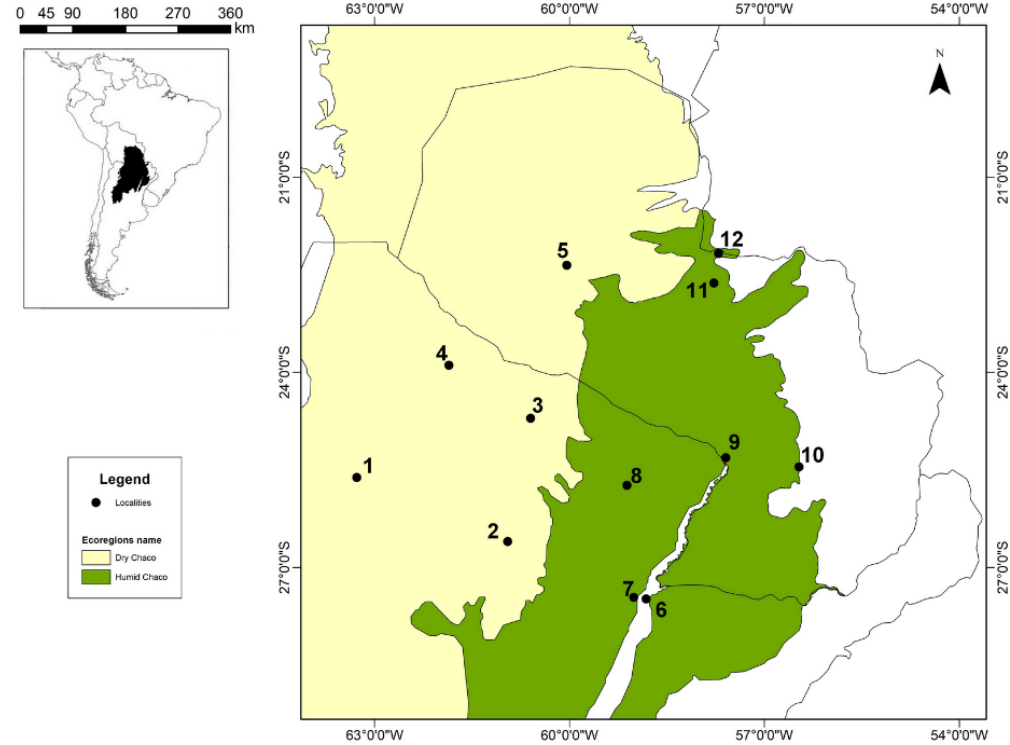
Figure 1. Geographic location of localities where studies on amphibian parasitic nematodes have been carried out in the Dry Chaco ecoregion (Argentina: 1. Taco Pozo, Chaco Province, 2. Concepción del Bermejo, Chaco Province, 3. Las Lomitas, Formosa Province, 4. Ingeniero Juárez, Formosa Province; Paraguay: 5. Boquerón, Boquerón Department) and in the Humid Chaco ecoregion (Argentina: 6. Corrientes, Corrientes Province, 7. Resistencia, Chaco Province, 8. Pirané, Formosa Province; Paraguay: 9. Asunción, Capital District, 10. Coronel Oviedo, Caaguazú Department, 11. Puerto Max, Concepción Department, 12. Estancia Estrellas, Concepción Department).